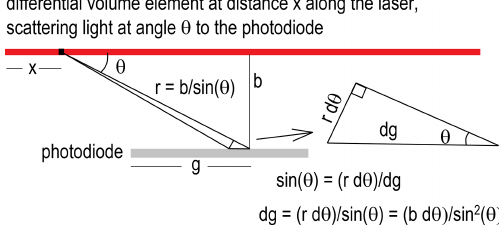
Figure A1. Sketch of PMS5003